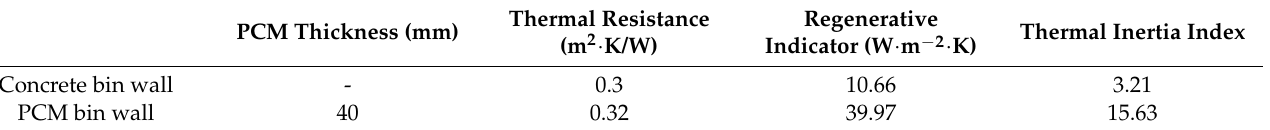
Table 5. The thermophysical properties of bin wall with and without PCM [38]. PCM Thickness